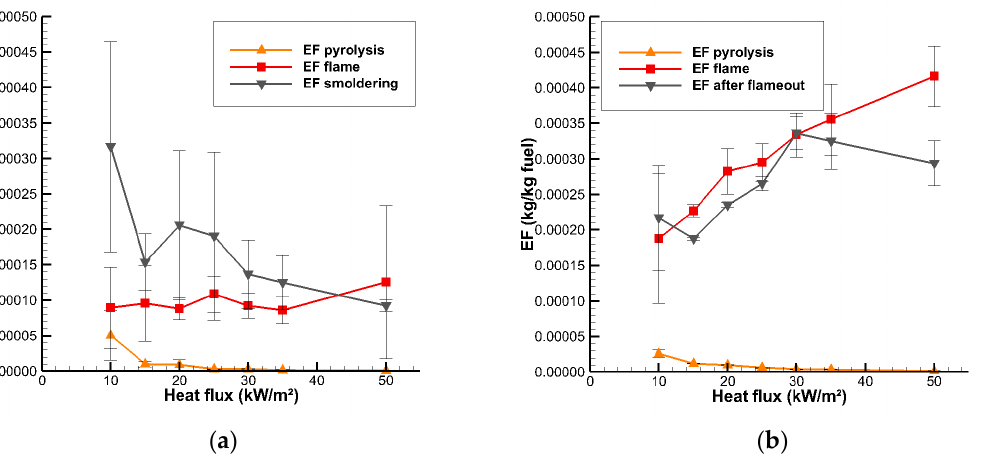
Figure 16. EF for C 2 H 4 for an imposed heat flux ranging from 10 to 50 kW/m 2 for ( a ) wood and ( b ) thermoplastic samples.